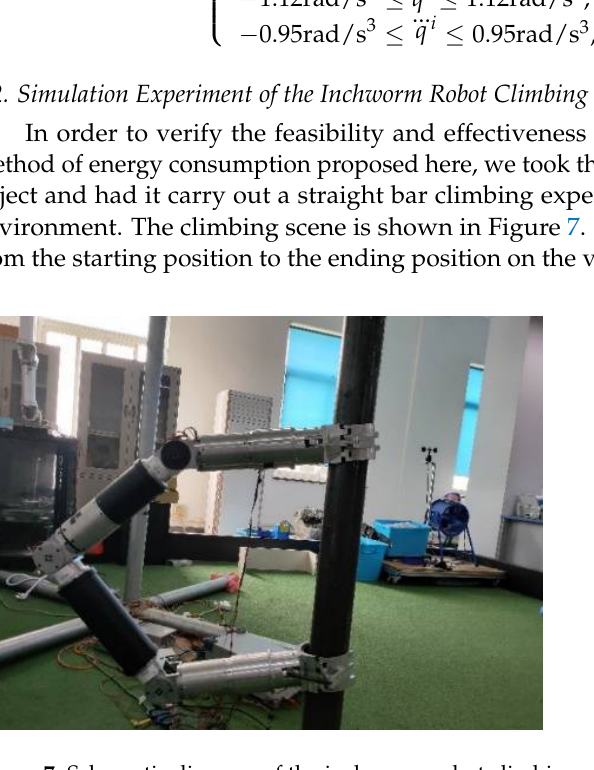
Figure 7. Schematic diagram of the inchworm robot climbing scene.